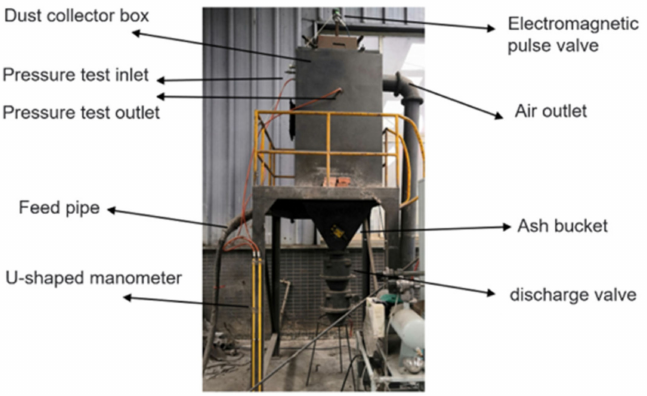
Figure 3. Vertical flat square cartridge filter.